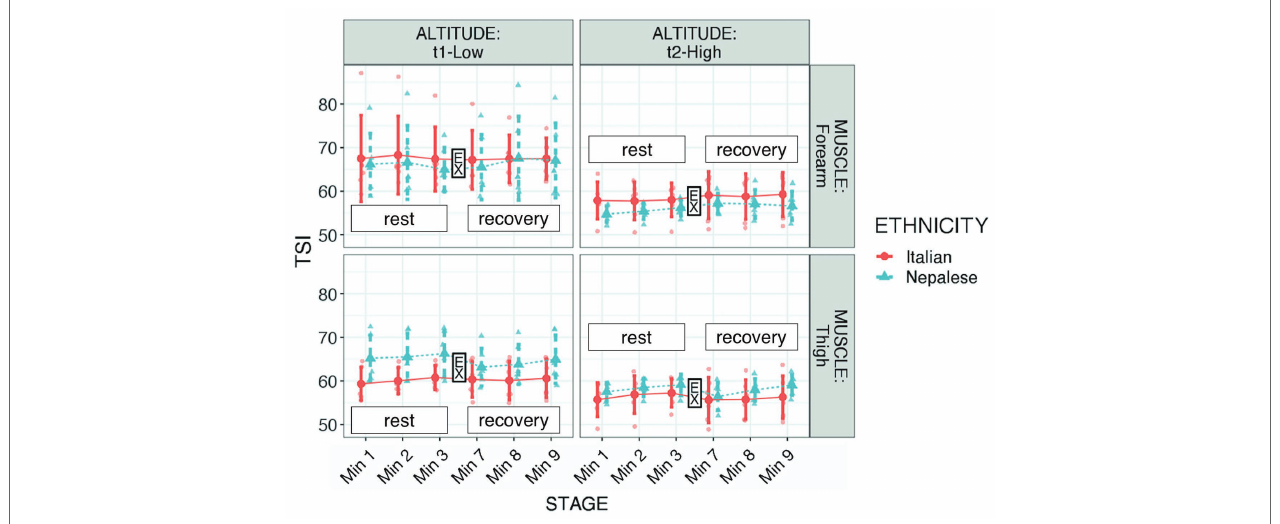
FIGURE 2 | Tissue saturation index (TSI) of participants during “Kanchenjunga Exploration & Physiology” project. Measurements were done with a NIRS device on forearm (upper panels) and anterior thigh (lower panels) , 3 min before (rest) and 3 min after (recovery) a 3-min-lasting exercise. EX represents the 3-min time spot of resistance exercise, constituted by 18 submaximal contractions. Both groups (Italians and Nepalese) were measured at low (1,450 m, left panels ) and high (4,750 m, right panels ) altitude. Data represent single values with mean ± SD, averaged by 1-min